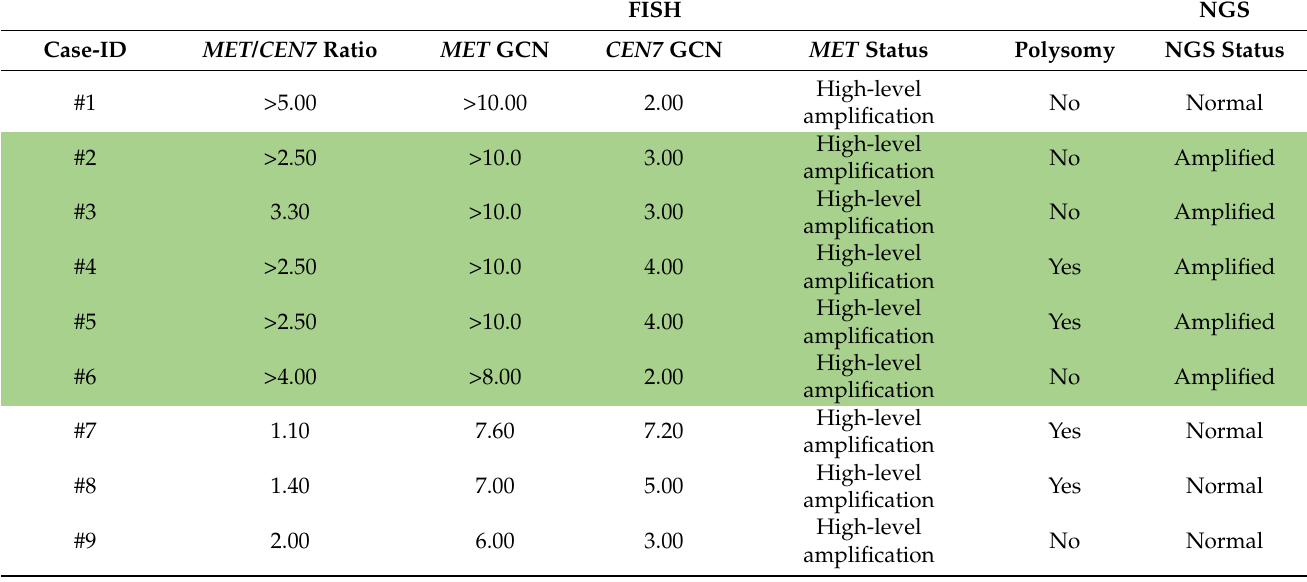
Table 1. Overview of the MET amplified cases assessed by FISH and NGS. Table showing cases #1–43 harboring an amplification of the MET gene determined by FISH or NGS. Cases are arranged according to their FISH classification, descending from high-level amplified cases to low-level amplified cases and descending from cases with the highest MET GCN to the lowest. The columns show the various FISH parameters ( MET / CEN7 ratio, MET GCN, CEN7 GCN, MET status and polysomy) as well as the NGS status. Cases which were classified as amplified by the NGS approach are highlighted in